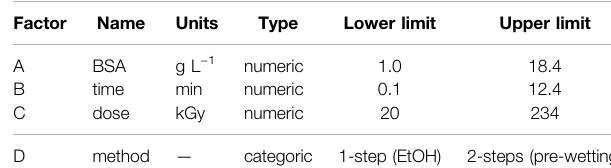
TABLE 3 | Investigated process factors of I-optimal RSM design. Given are the simpli fi ed names (see Table 1 ), units, and each a lowest, and highest factor level limit, respectively. Please note, the categoric factor ‘ method ’ was introduced as combination of the two previous factors describing possible impregnation methods, i.e ., preceding pre-wetting step, or addition of EtOH to the impregnation